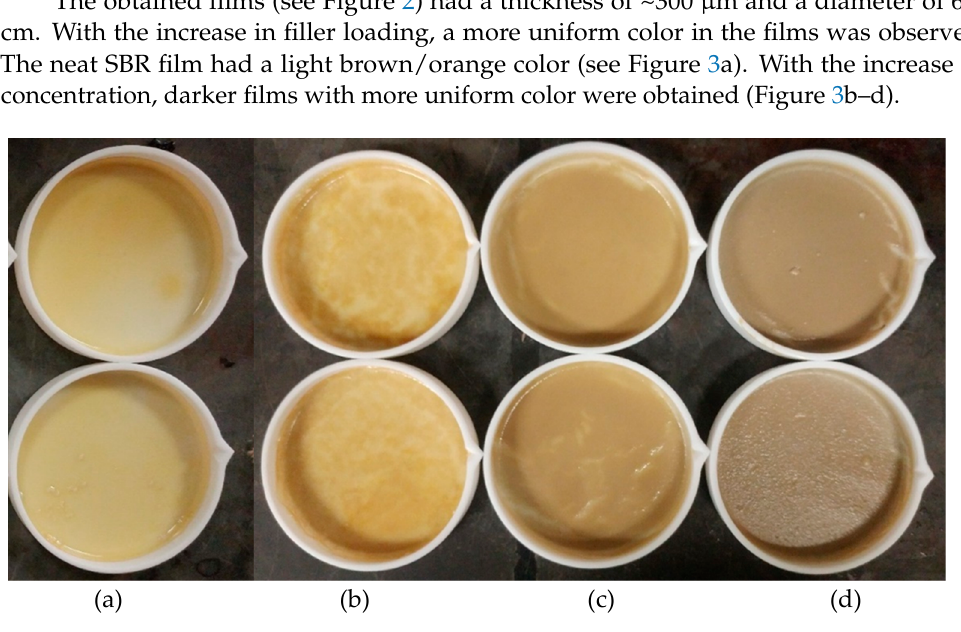
Figure 3. SBR composites obtained by solvent casting containing 0 wt% ( a ), 1 wt% ( b ), 5 wt% ( c ), and 10 wt% ( d ) of